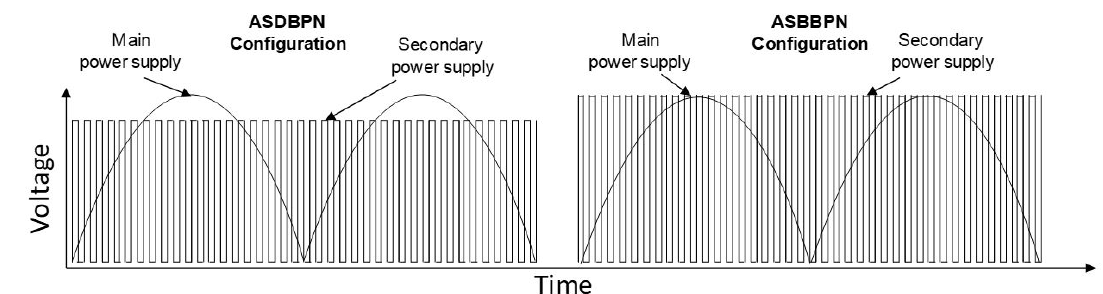
Figure 2. Voltage waveform in active screen (main power supply) and in samples (secondary power supply).